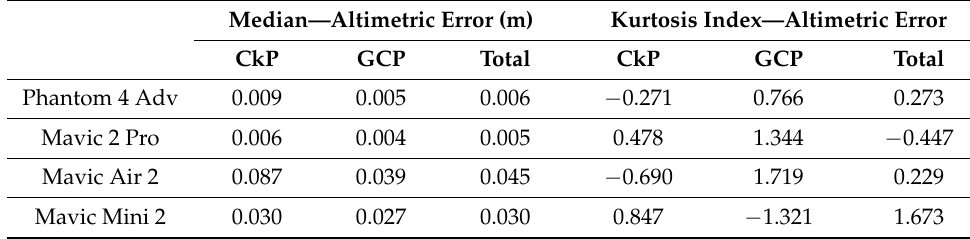
Table 9. Median calculated for the altimetric